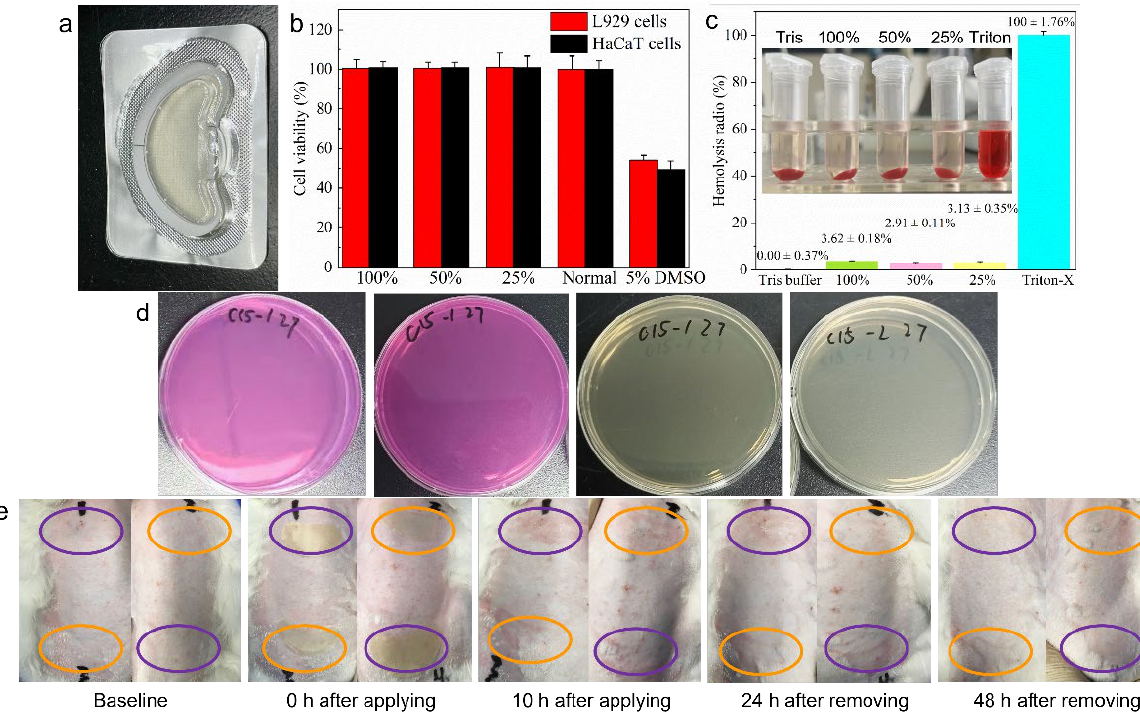
Figure 4. A systemic safety evaluation of complex polypeptide-loaded dissolving microneedles. The packaged CP-DMNs with sterilized blister and aluminum–plastic bag ( a ). The cell viability results of CP-DMNs for L929 and HaCaT cells ( b ). The results of erythrocyte hemolysis for CP-DMNs ( c ). The LTNA and RBA plates after being incubated to check the existence of bacteria, mold and yeast in CP-DMNs ( d ). The in vivo skin irritation research of CP-DMNs on rabbits’ skin ( e ).